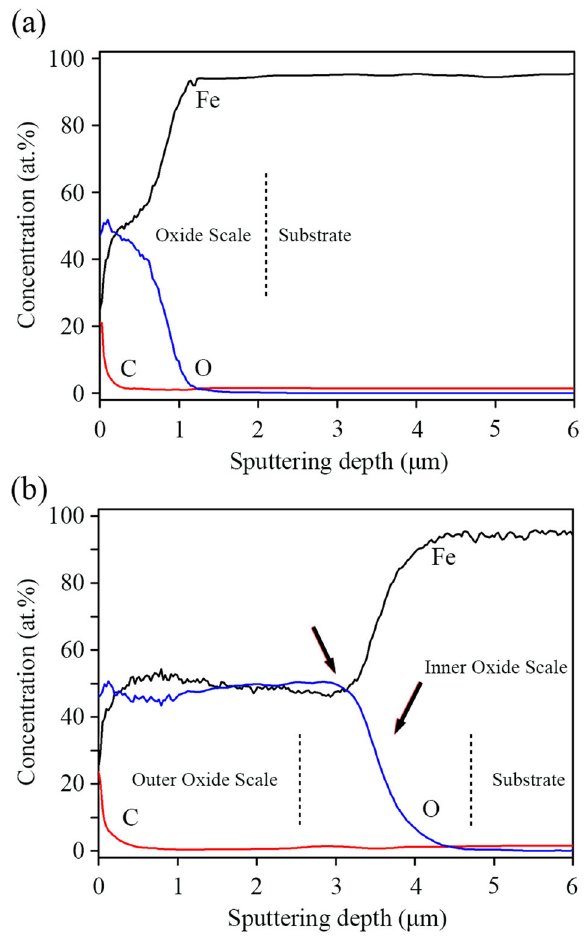
Fig. 6 Concentration distribution of elements Fe, O, and C on 37Mn5 steels after oxidation for 30 min at 700 °C by GDOES. a In air. b In kerosene